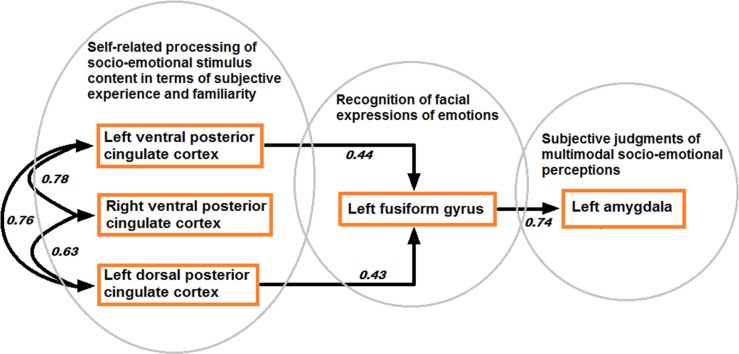
Model of directional effects (indicating standardized path coefficients) between posterior cingulate cortex, fusiform gyrus, and amygdala obtained by SEM for the differentiation between congruent and incongruent stimuli, and a recapitulation of the task-related fMRI results concerning the encoding of socio-emotional stimulus congruence within the network.